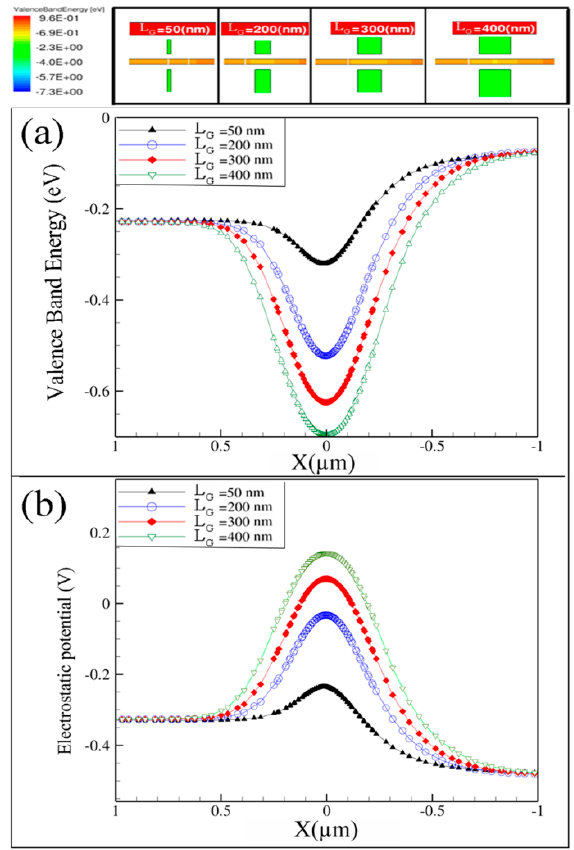
Figure 4. ( a )The variation of valence band edge energy and ( b ) electrostatic potential from the source to the drain contact for different L G , at V D = − 1 V and V G = +2 V. to the drain contact for di ff erent L G , at V D = − 1 V and V G = + 2